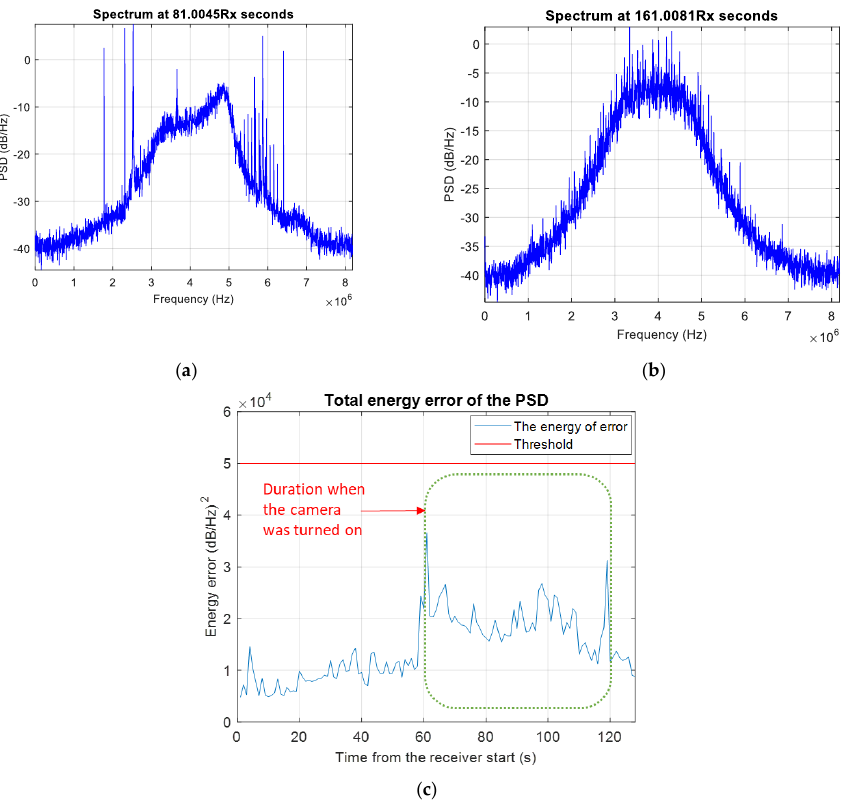
Figure 15. The PSD observed when the camera is ( a ) on (from second 60 to second 120), ( b ) off (the rest) and ( c ) the total energy of error measured during the experiment.